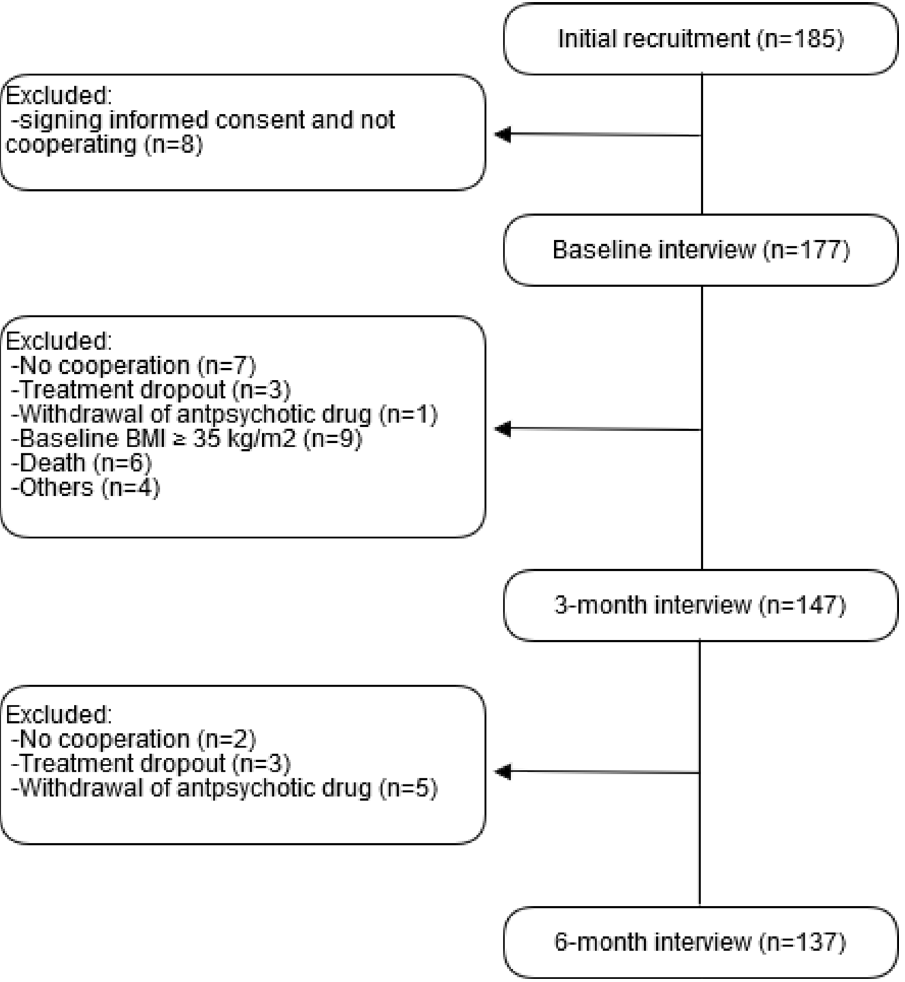
Figure 1. Flowchart of the patients’ follow-up. Main baseline characteristics of those patients who fulfil inclusion criteria but were lost to follow-up (n = 39): age, 56.2 years (55.2 years in the final cohort); mean BMI, 23.8 kg/m 2 (25.5 in the final cohort); females, 44.7% (63.5% in the final cohort). They did not substantially differ from those who were finally